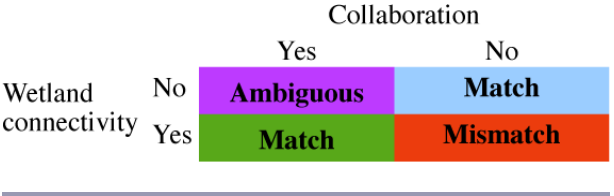
Fig. 4 . Types of social-ecological fit analyzed. Red represents mismatches with a high level of wetland connectivity but no collaboration. Purple denotes that wetland managers do communicate, although there is little or no wetland connectivity; we call these “ambiguous mismatches” since the collaboration might still be relevant to wetland connectivity of types other than those assessed in this study (e.g., through hydrology), or it may be instrumental to initiate a wetland restoration project. This color coding is used in Fig. 6 and Fig.